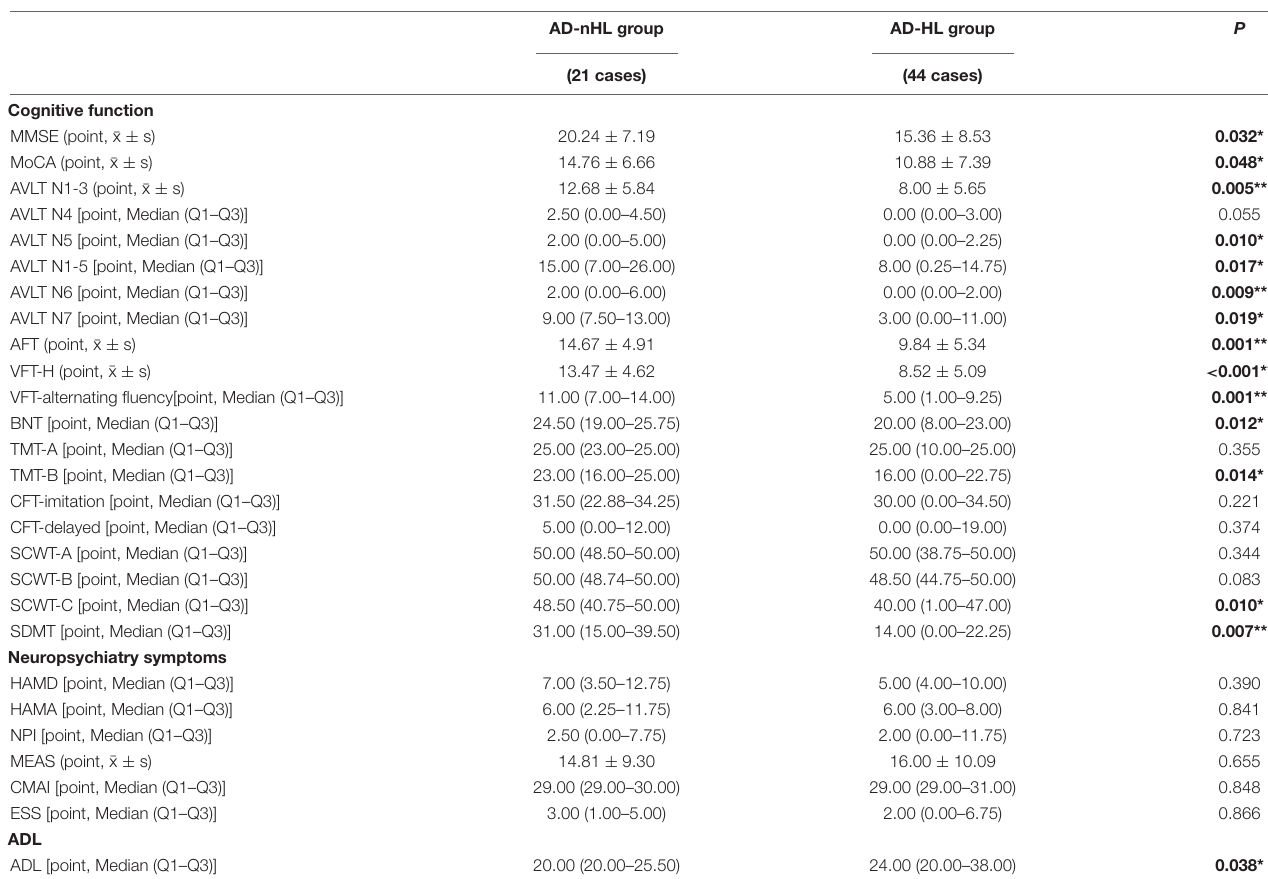
TABLE 2 | Cognitive function, neuropsychiatry symptoms, and activities of daily living (ADL) between AD-nHL and AD-HL groups. AD-nHL